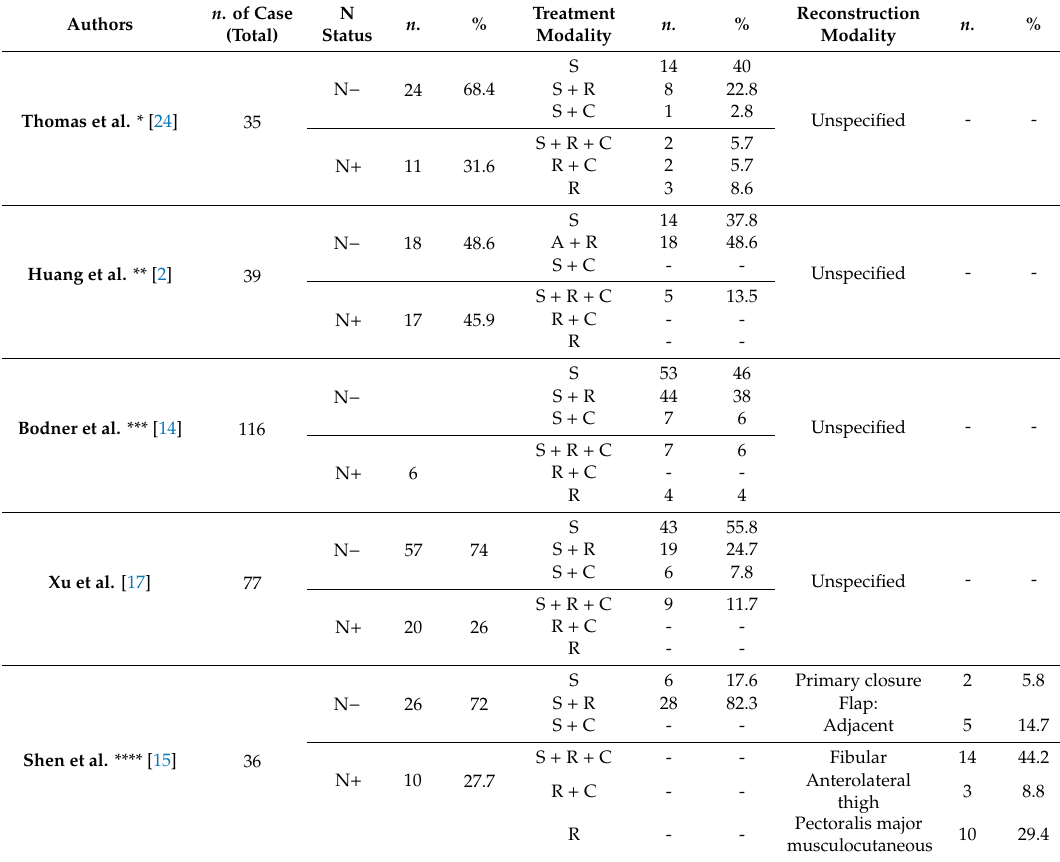
Table 4. Lymph node status at the time of diagnosis, treatment, and reconstruction modalities by various